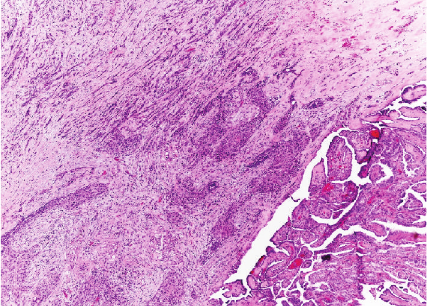
Figure 6: A significant rate of ATC is associated with WDTC. In this case, residual foci of papillary carcinoma are seen in the lower right corner but the main bulk of the tumor is composed of strands of squamoid atypical cells and spindle neoplastic